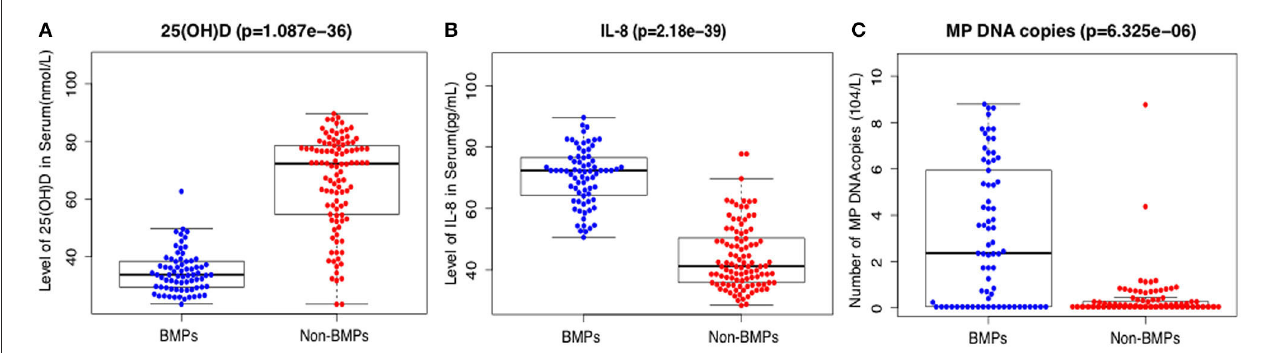
FIGURE1 Comparison of serum levels of 25(OH)D (A) , IL-8 (B) , and number of MP DNA copies (C) in the BMP group and the non-BMP group.